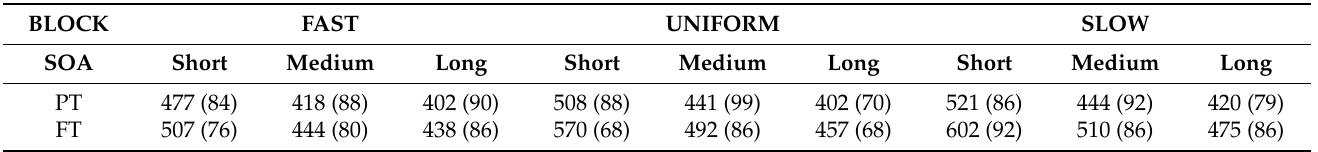
Table 3. Response speed. Mean and standard deviation (in parentheses) measures of response speed (reaction times) for preterm (PT) and full-term (FT) children for each experimental